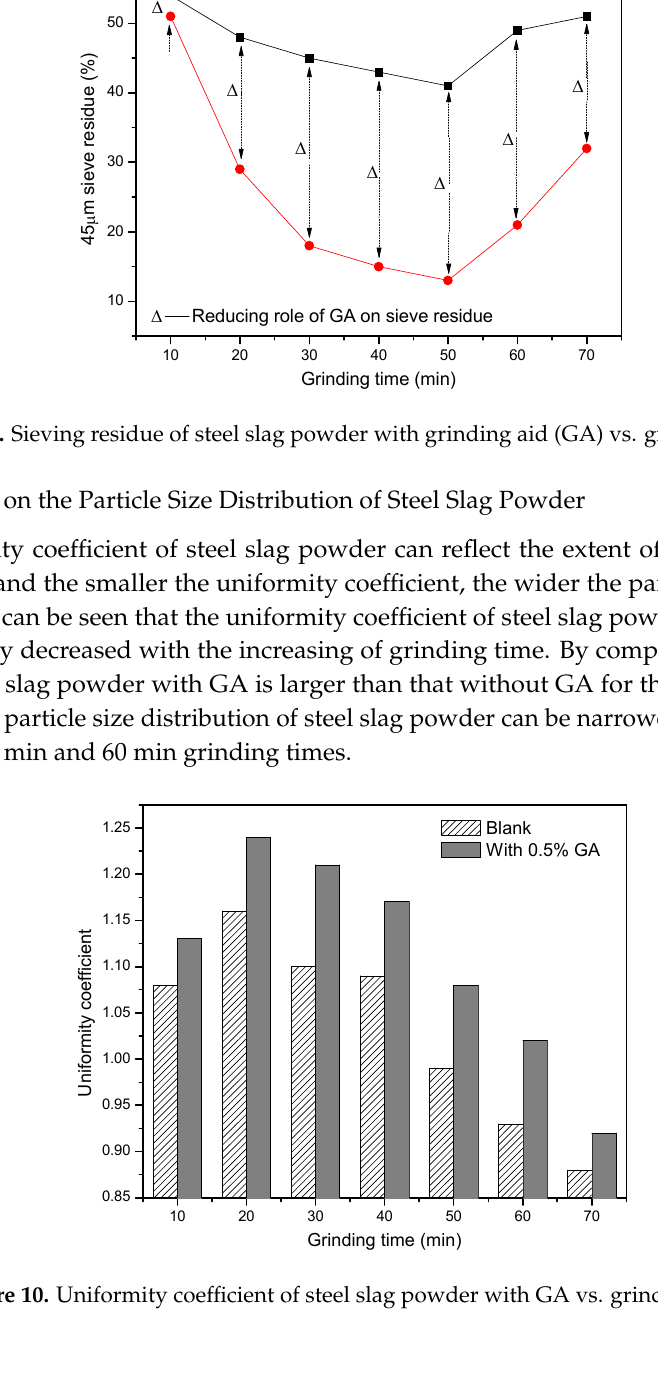
( b ) Figure 8. Particle morphology of ground steel slag powder after 50min grinding time: ( a ) untreated steel slag; ( b ) pretreated steel slag. 3.4. Effect of Organic Grinding Aids on the Grinding Property of Converter Steel Slag From the above results of studies, it can be seen that the agglomeration phenomenon of fine particles will occur during deep grinding periods, which seriously affect or reduce the grinding efficiency of steel slag. In recent years, organic grinding aids (GA) have been used to improve the grinding efficiency of cement. These researches show that organic GA molecules can be adsorbed on the particles and effectively weaken the agglomeration of fine particle in the grinding process, thus improving the dispersion of powder and grinding efficiency [28–31]. Therefore, it is a good choice to